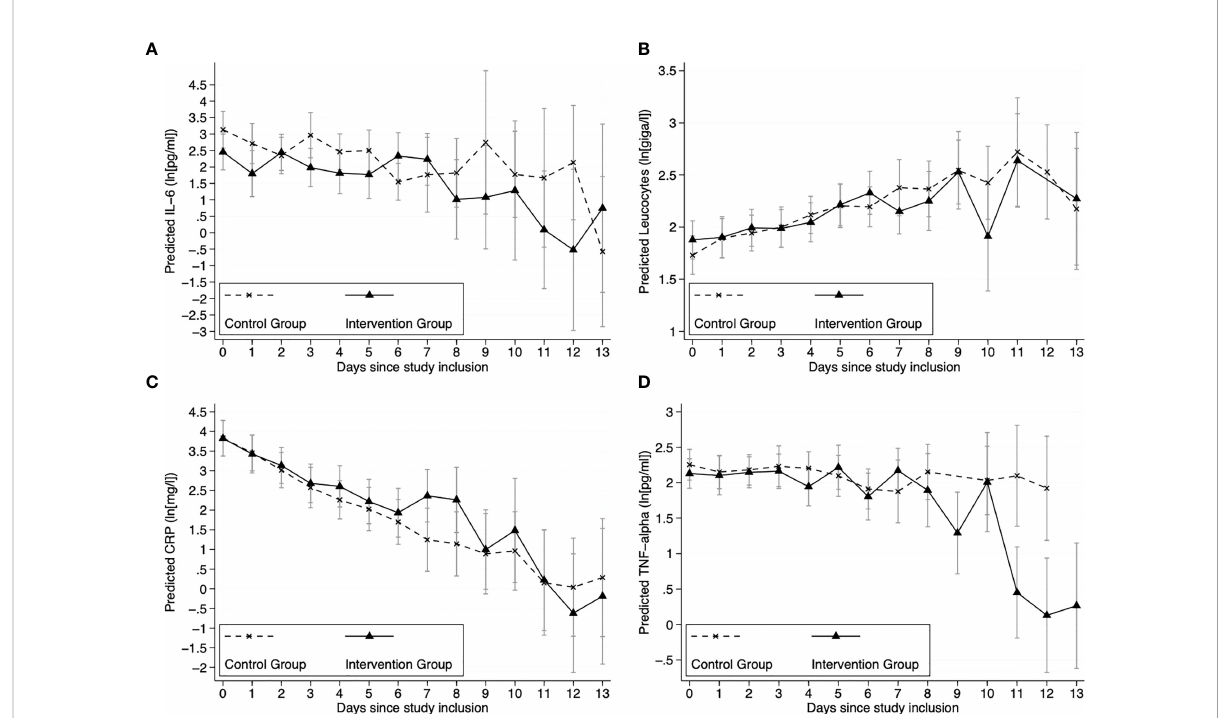
FIGURE 2 Trajectories of in fl ammatory outcomes. Marginal mean prediction of (A) ln(IL-6[pg/ml]), (B) ln(leucocytes[giga/l]), (C) ln(CRP[mg/l)] and (D) ln(TNF- a [pg/ml]) values for IG and CG from multilevel fi xed-effect linear regression models with random slope (N = 46 individuals with N = 208 observations; average observations per individual=4.5). Note: Negative ln values translate to parameter values <1. Covariates: relevant comorbidities (no vs. yes), COVID-19 pneumonia medication (count), and age (years). Model predictions were calculated at covariate mean